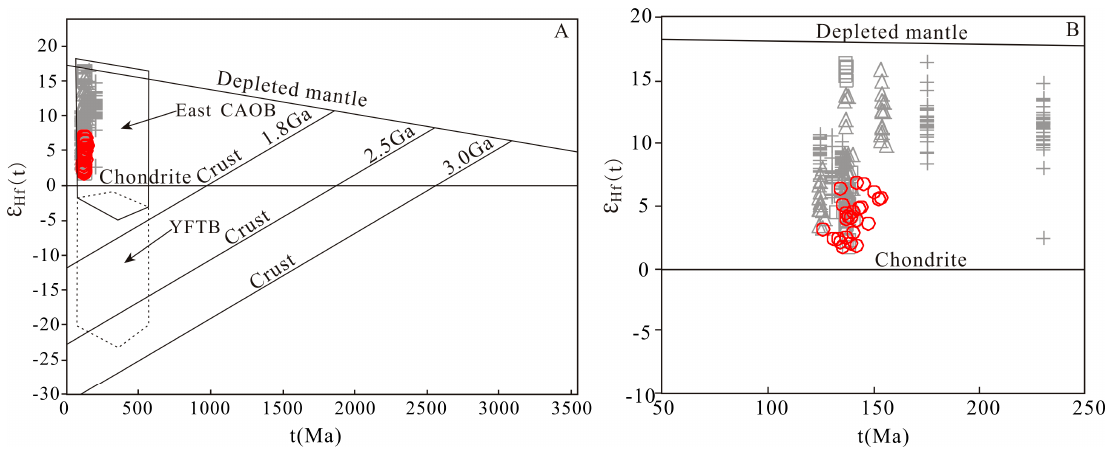
Figure 9. Variations of ε Hf (t) versus crystallization age of zircons ( A , B ) of the Weilasituo Sn-polymetallic deposit. The gray areas of granite is quoted from [20,61,62].